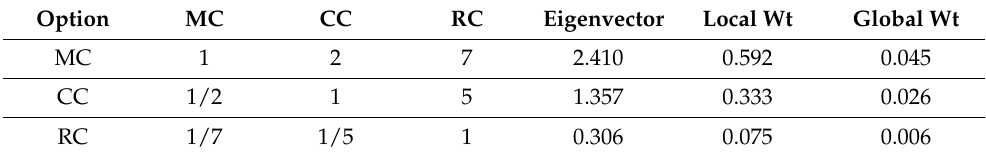
Table A13. Comparison of alternatives matrix for subcriterion SA9.